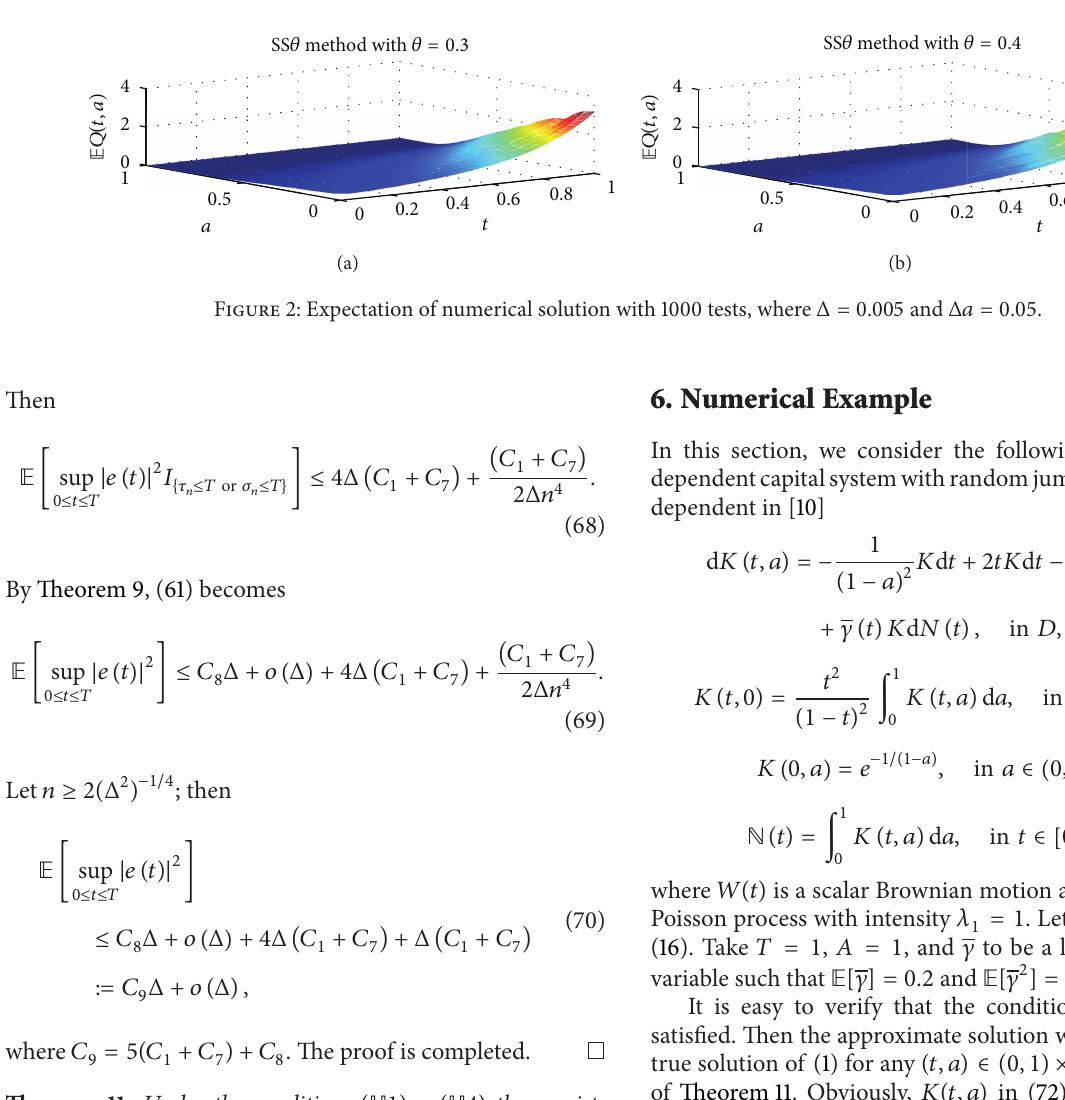
Figure 1: Expectation of numerical solution with 1000 tests, where Δ = 0.005 and Δ𝑎 = 0.05 .